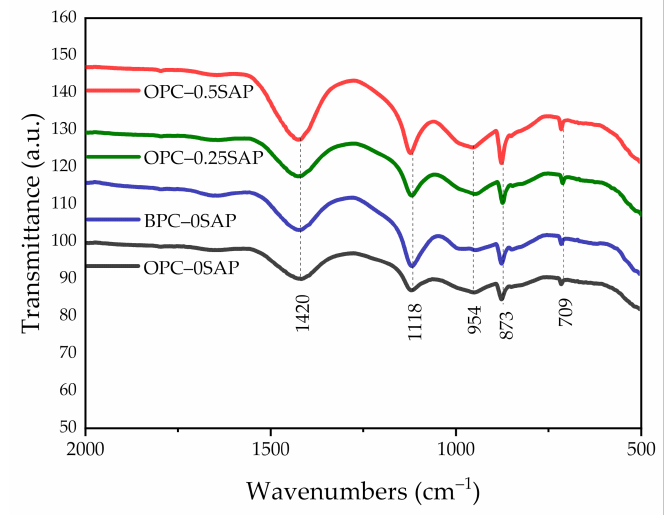
Figure 14. ATR–FTIR spectra of all samples for 28 days.